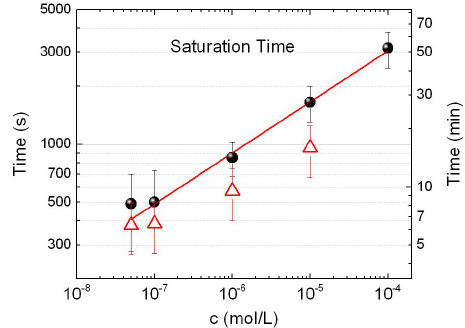
Figure 5. Saturation time (black dots) plotted against BSA concentration. Each point is the average of the saturation times for at least three different aggregates. Red line is power law fit with exponent 0.26 ± 0.01 (best fit parameter). Red symbols are estimated values for T sat from the hydrodynamic model in Supplementary Note 1.